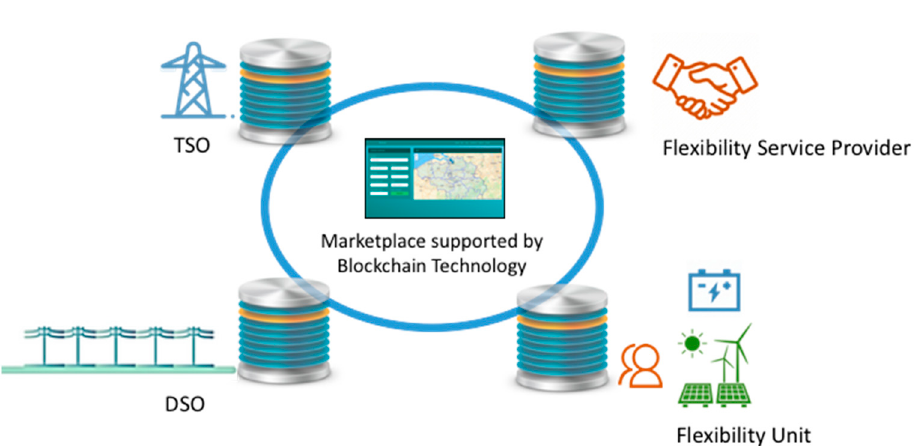
Figure 17. TSO-DSO coordination using Blockchain.